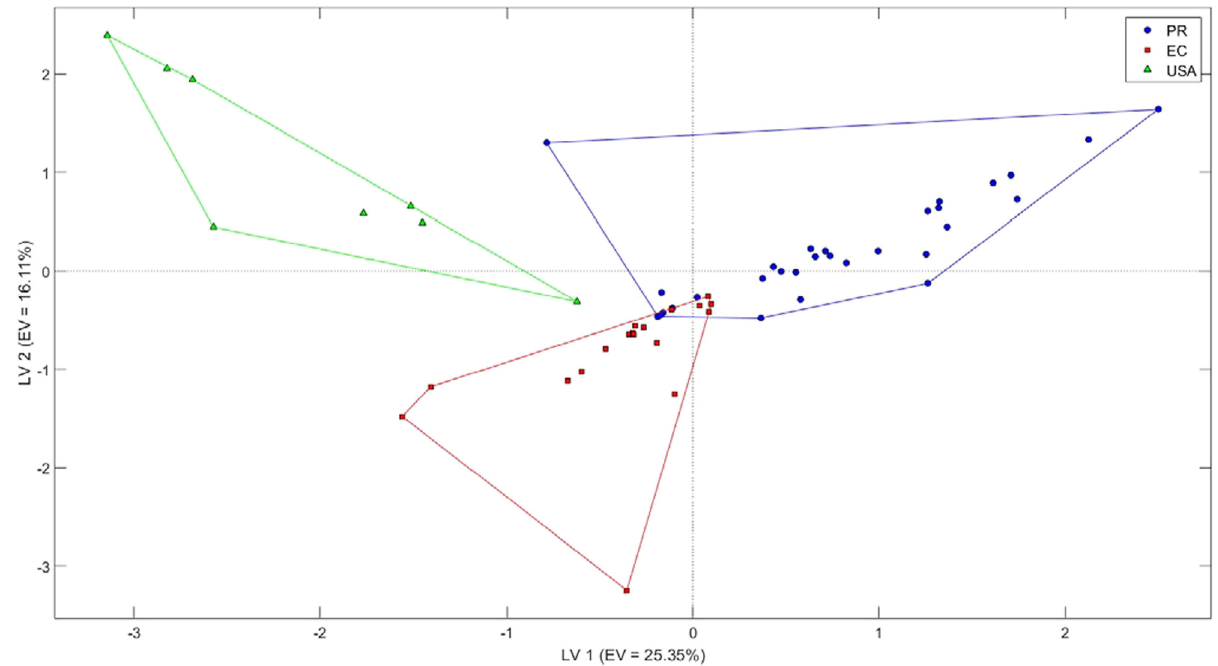
Figure 11: PLS score plot showing di ff erent cheeses. PR is represented by blue circles, EC by red squares, and US competitors ( USA ) by green triangles. Reprinted with permission from ref. [ 70 ]